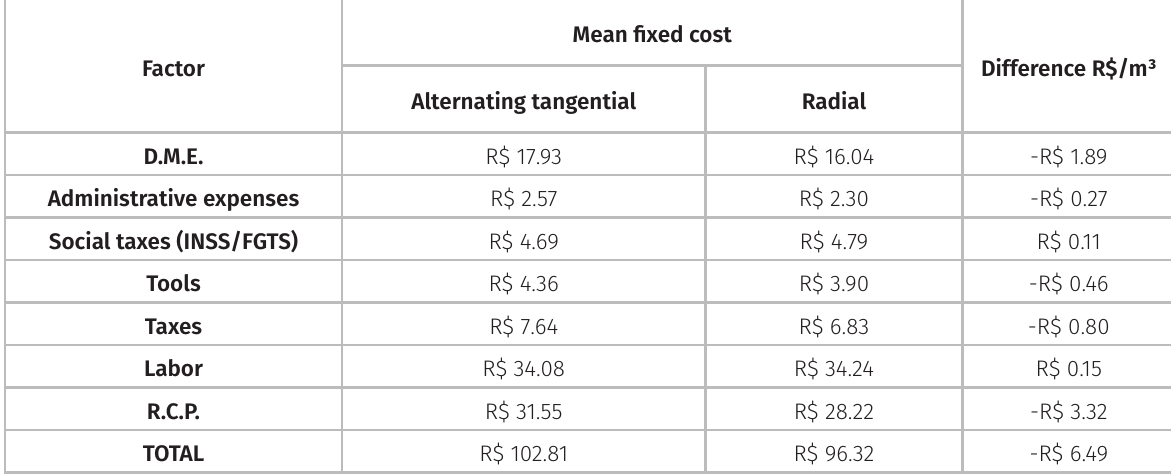
Table IV. Percentage of mean fixed costs for the alternating sawing pattern and radial sawing